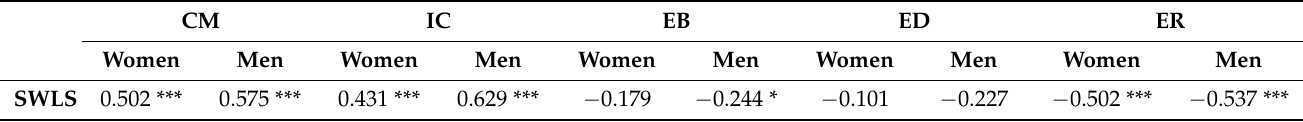
In first-time fathers, moderate and positive correlations concern the relation between life satisfaction and intensity of positive emotions in the given moment (S-P) ( r = 0.431; p < 0.001) and usually (C-P) ( r = 0.459; p < 0.001). The relation between life satisfaction and intensity of negative emotions usually (C-N) is weak and negative ( r = − 0.282; p < 0.05). No relation was observed between life satisfaction and negative emotions experienced in the given moment (S-N) ( r = − 0.198; p > 0.05) (Table 12). In the group of women, there are moderate positive relations between life satisfaction and commitment making (CM) ( r = 0.502; p < 0.001), identification with commitment (IC) ( r = 0.431; p < 0.001), and moderate negative relation between satisfaction and ruminative exploration (ER) ( r = − 0.502; p < 0.001) (Table 13). Table 13. Pearson’s r correlation coefficients between the dimensions of identity and life satisfaction at examined parents. CM